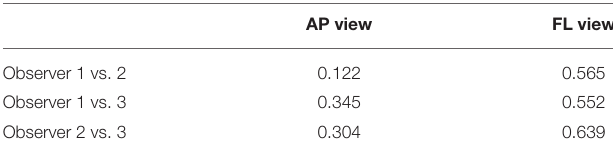
TABLE 1 | The Kappa value among observers for evaluating the AP view and FL view.